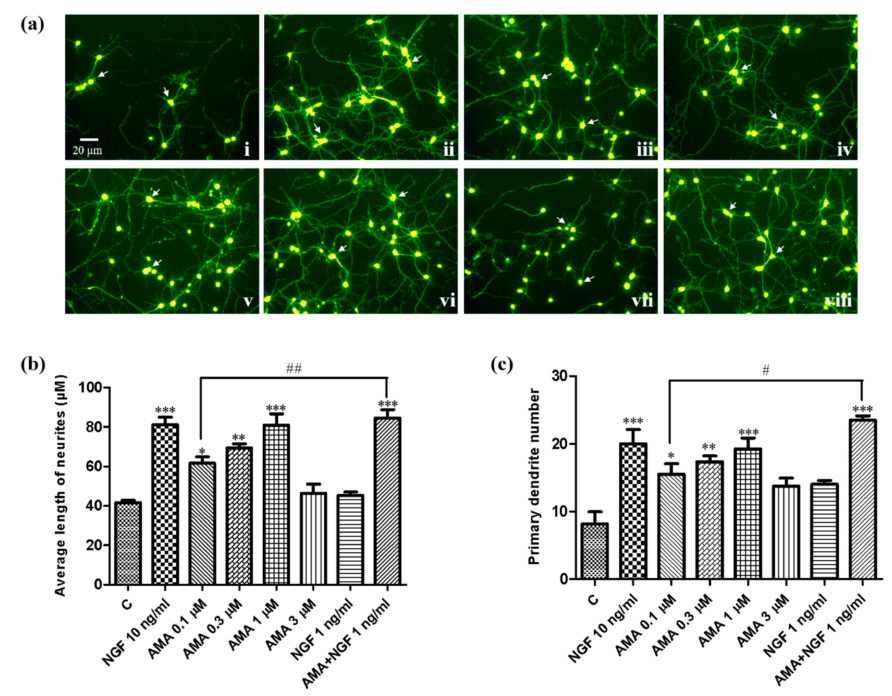
Figure 2. Neurogenesis effect of AMA in primary cortical neuron cells. ( a ) Micrographs of primary cortical neuron cells at 48 h after treatment with ( i ) control (0.5% DMSO); ( ii ) NGF (10 ng/mL); ( iii ) NGF (1 ng/mL); ( iv ) AMA (0.1 µ M); ( v ) AMA (0.3 µ M); ( vi ) AMA (1 µ M); ( vii ) AMA (3 µ M); ( viii ) AMA (0.1 µ M) + NGF (1 ng/mL). ( b ) Average length of neurite outgrowth of the